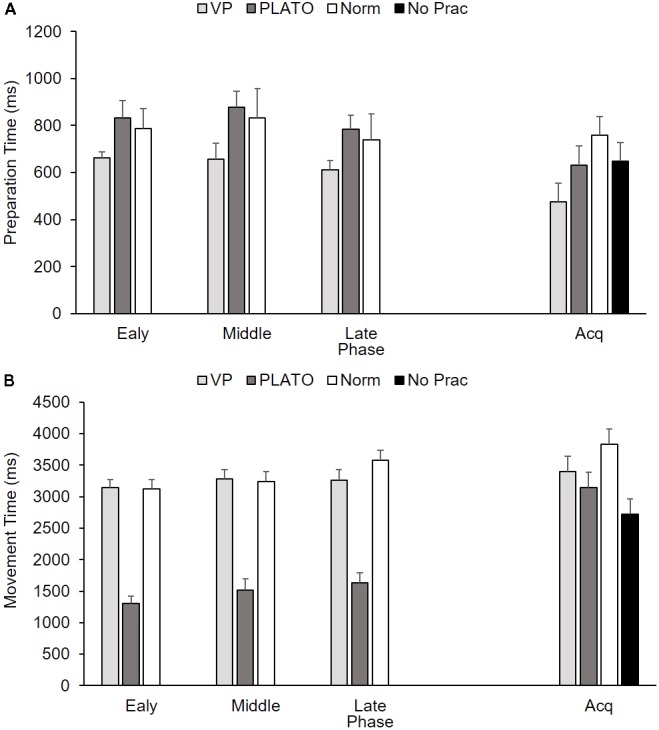
Group mean (+SEM) preparation time (A) and movement time (B) as a function of group (VP-Nike Vapor Strobe®; PL - PLATO Visual Occlusion; Norm - Normal Vision; No Prac - Control) across practice phase (early, middle, and late) and acquisition (Acq). There is no practice data for the control group as they did not complete any perceptual-motor training. NB. Means for acquisition reflect post-test means adjusted based on the pre-test scores (Preparation time = 920 ms; Movement time = 2521 ms).